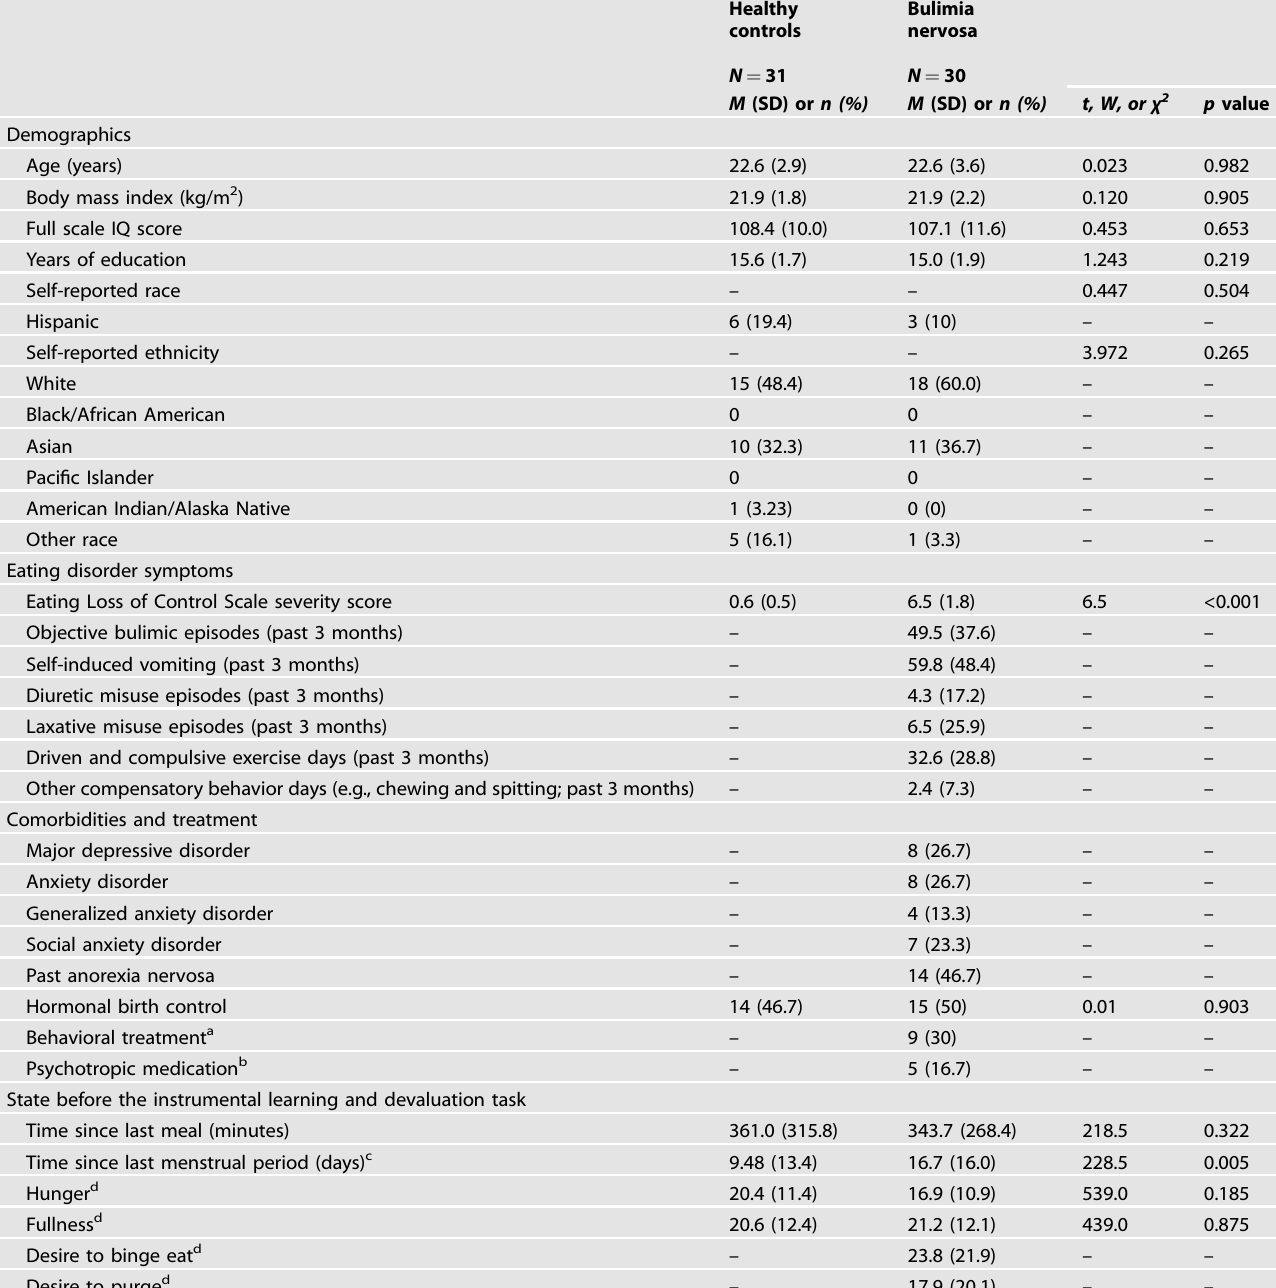
Table 1. Sample characteristics and state